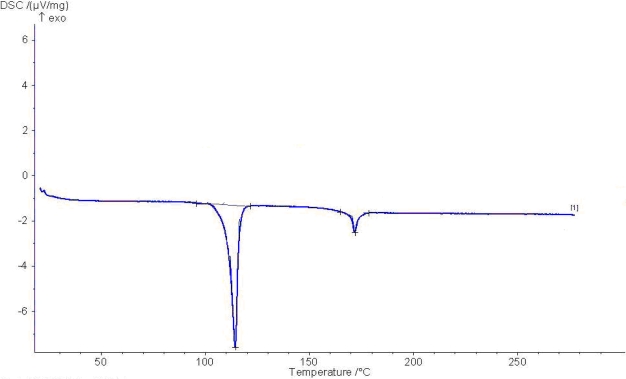
DSC thermogram for E-SR8.